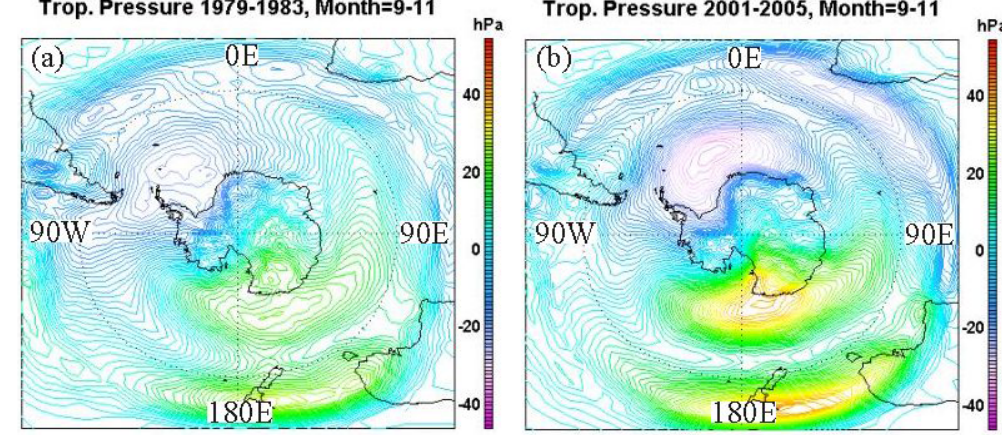
Fig. 11. Eddy field of tropopause pressure for September–November (a) 1979–1983 and (b) 2001–2005 from the NCEP-NCAR reanalysis